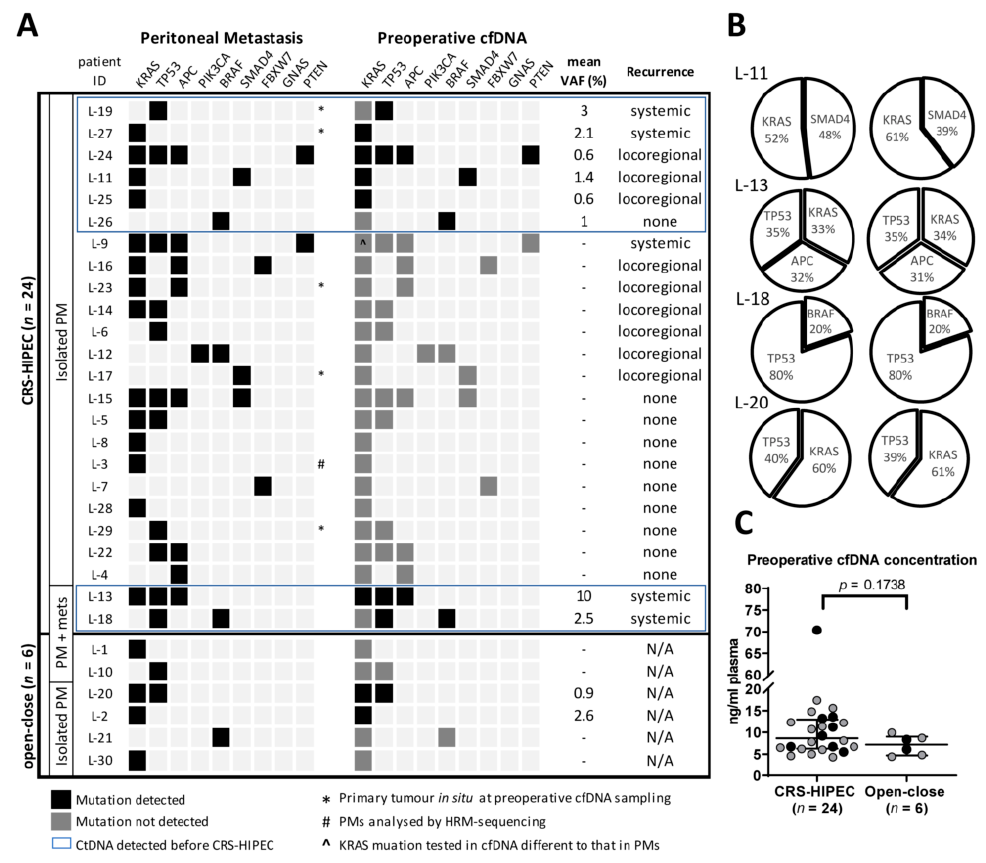
Figure 2. ( A ) An overview of the genes in which a somatic mutation was identified in peritoneal metastases (PMs) and tested for in the corresponding preoperative cfDNA sample. A black square indicates that the mutation was identified in both PMs and cfDNA; a grey square indicates a negative result for the corresponding mutations in the cfDNA. All cfDNA samples were tested using the KRAS G12 / 13 screening kit. ( B ) Comparison of the relative proportion of mutations detected in PMs and preoperative cfDNA samples. ( C ) Concentration of cfDNA samples. A black dot denotes that ctDNA was detected; lines indicate the median and the interquartile range. HRM-sequencing: High-Resolution Melting assay followed by Sanger sequencing.